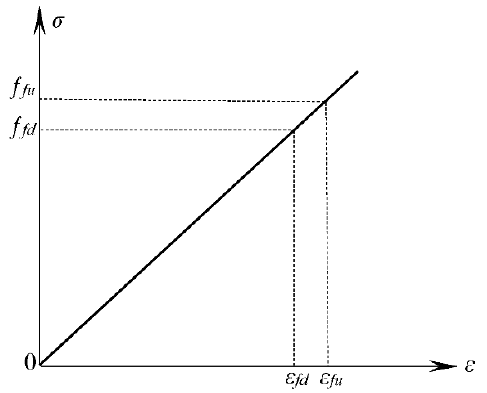
Figure 10. Stress–strain of the FRP bar.